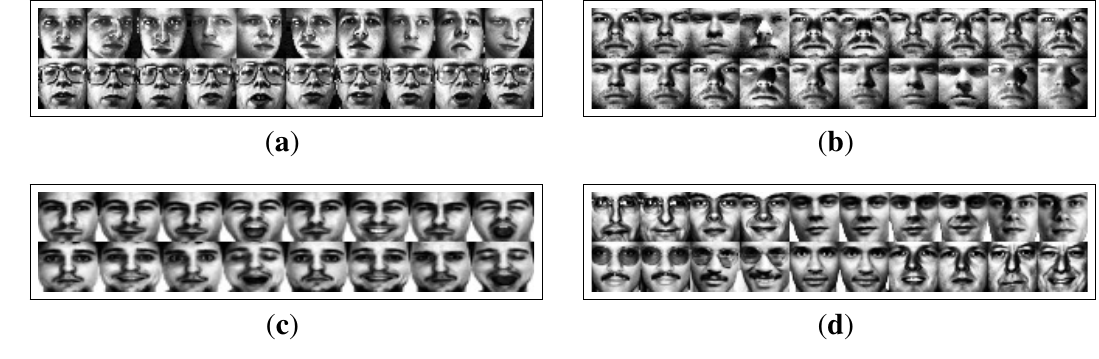
Figure 11. Four databases used in the experiments: ( a ) ORL; ( b ) Extended Yale (Yale2); ( c ) AR; ( d )